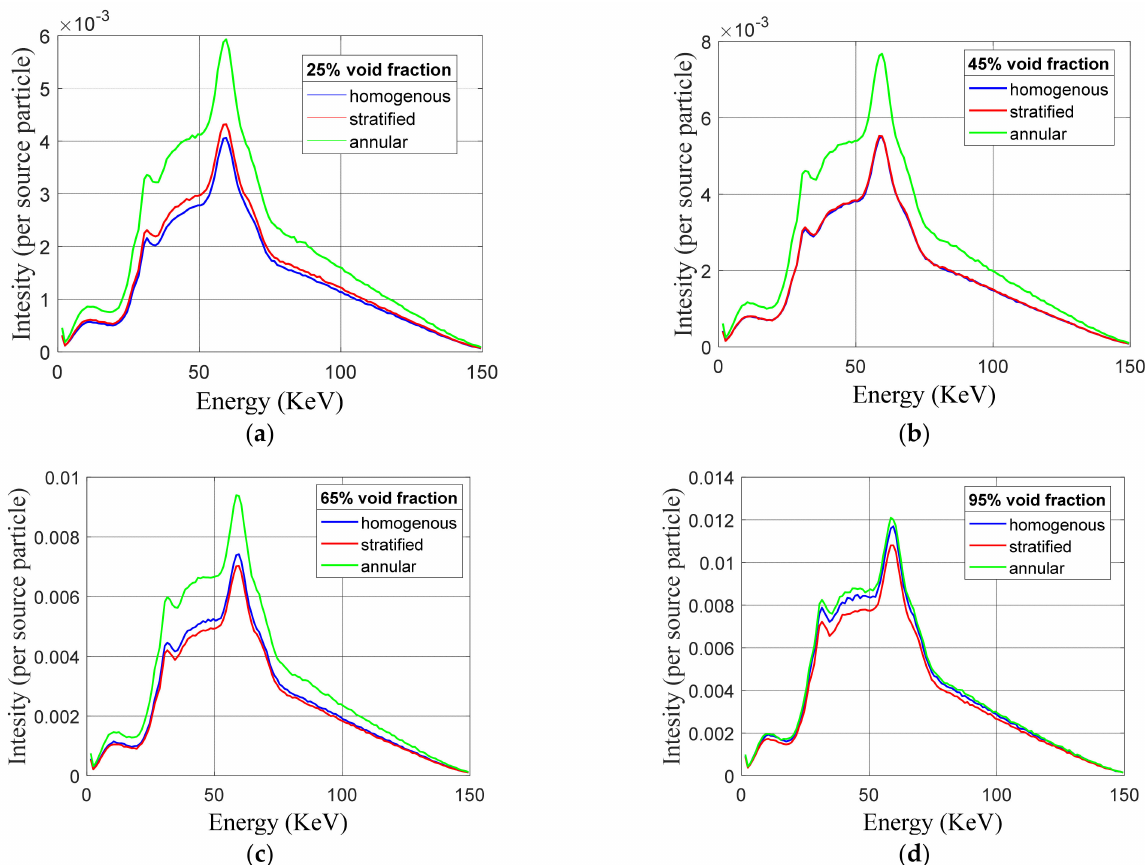
Figure 5. Recorded spectra in the detector for different void fractions of: ( a ) 25%, ( b ) 45%, ( c ) 65%, ( d )